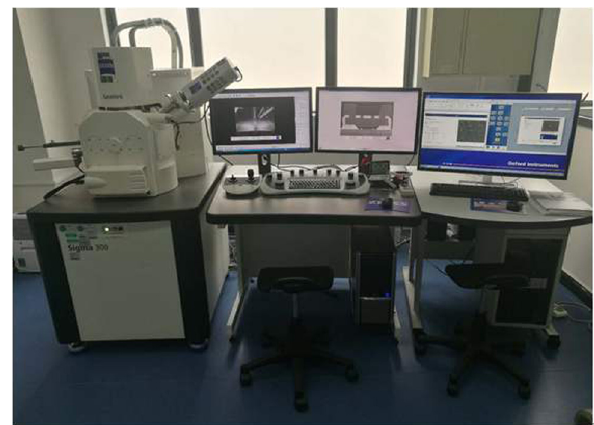
Figure 5: Scanning electron microscope.